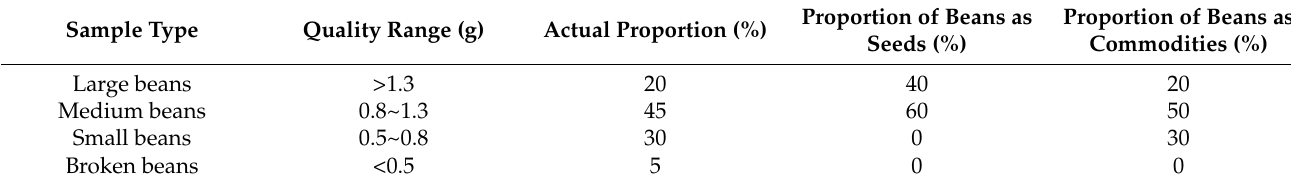
Figure 1. Cyperus esculentus samples: ( a ) large beans; ( b ) medium beans; ( c ) small beans. Table 1. Classification and proportion of Cyperus esculentus